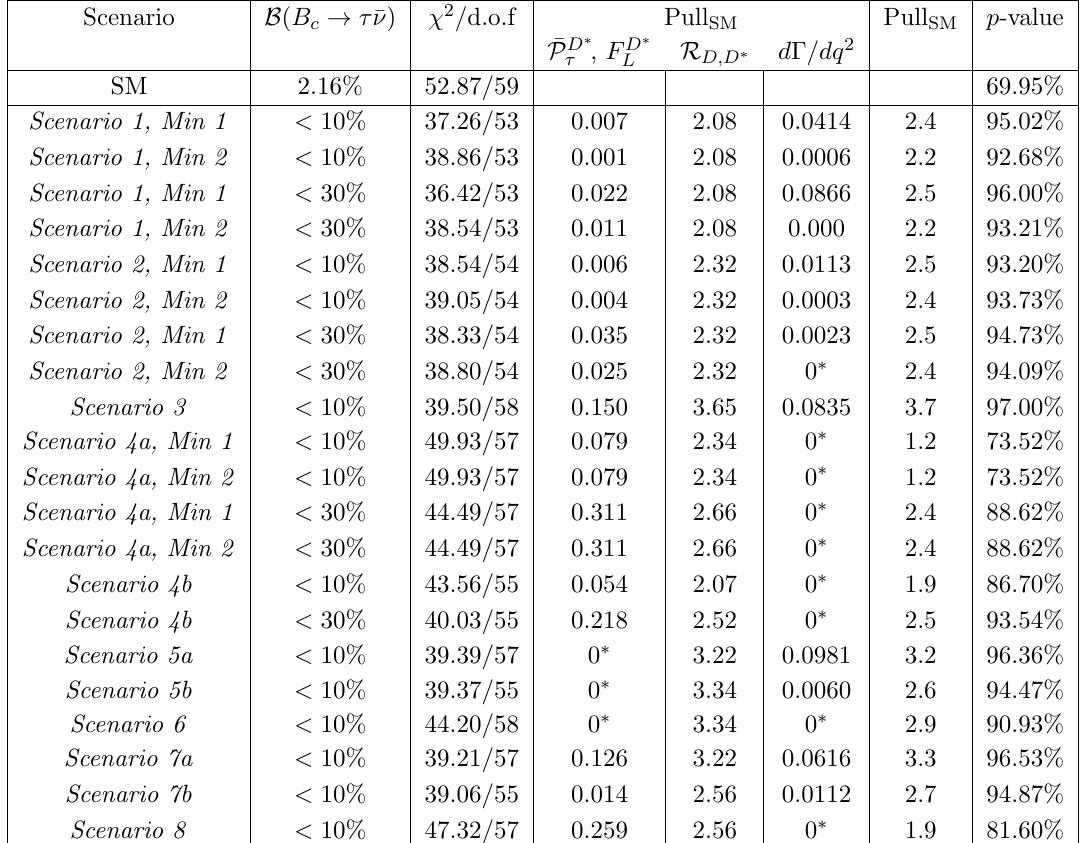
Table 3 . Fit quality of the di(cid:11)erent (cid:12)ts: (cid:31) 2 = d.o.f, pulls with respect to the SM hypothesis and p -values. The (cid:3) symbol indicates that the (cid:31) 2 of a given scenario is greater than the SM one. (cid:12)tted results, specially when comparing scenarios with close pull values. The quantitative estimate of the induced bias depends strongly on the experimental set-up and is beyond the scope of a global analysis, including data from several (cid:13)avour